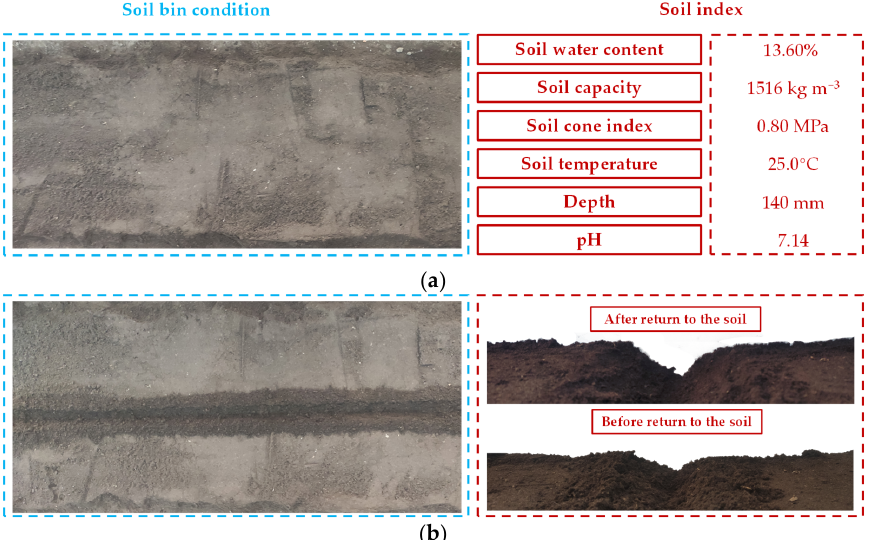
Figure 5. Indoor soil bin conditions and test process. ( a ) Soil conditions and parameters of the indoor soil bin test; ( b ) extraction process and results of soil gully contour parameters.